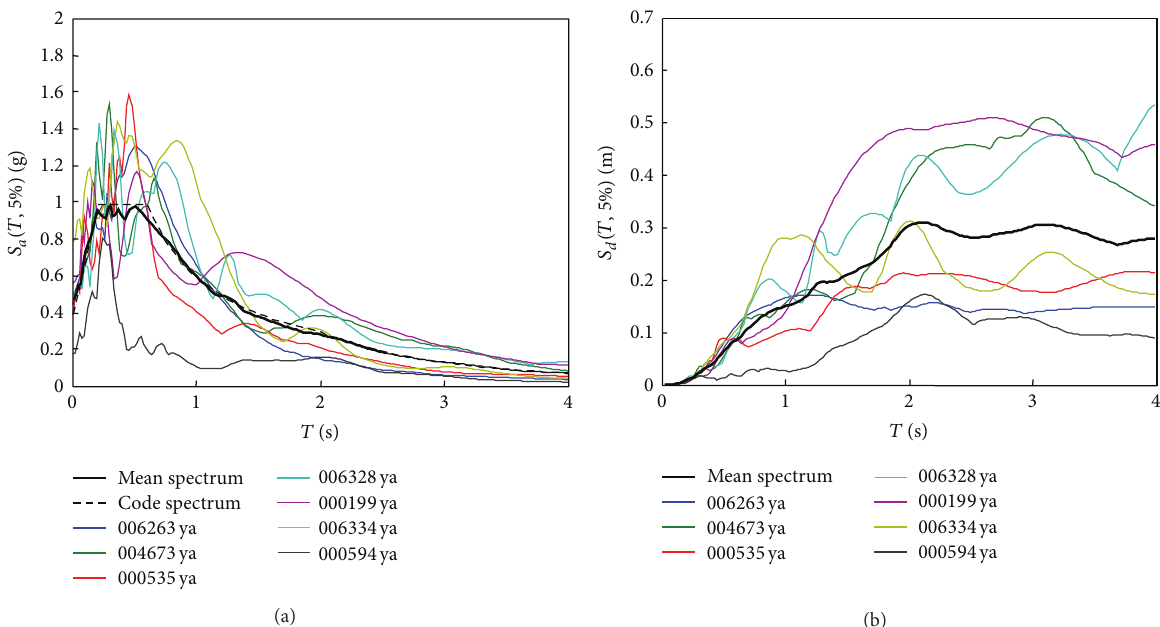
Figure 3: Variation with period 𝑇 of the pseudo-acceleration response spectrum 𝑆 𝑎 (𝑇,5 % ) (a) and of the displacement response spectrum (𝑇,5 % ) (b) of natural records. 𝑆 𝑑